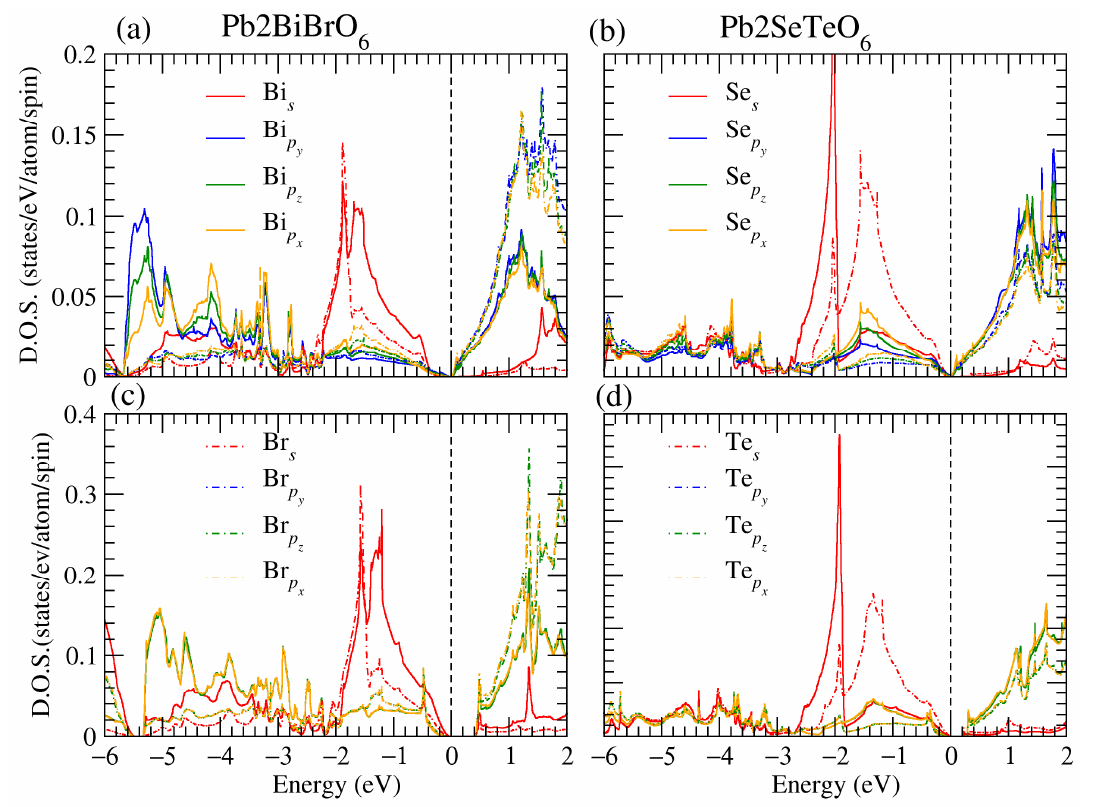
Figure 3. Scalar relativistic, ( a , b ), and fully relativistic, ( c , d ), electronic band structures of the Pb 2 BiBrO 6 and Pb 2 SeTeO 6 double perovskites projected onto the s -(red) and p -(blue) orbitals. Note that only BiBr (SeTe) s - and p -orbitals are projected. The Fermi energy is shifted to zero as a refer- ence.